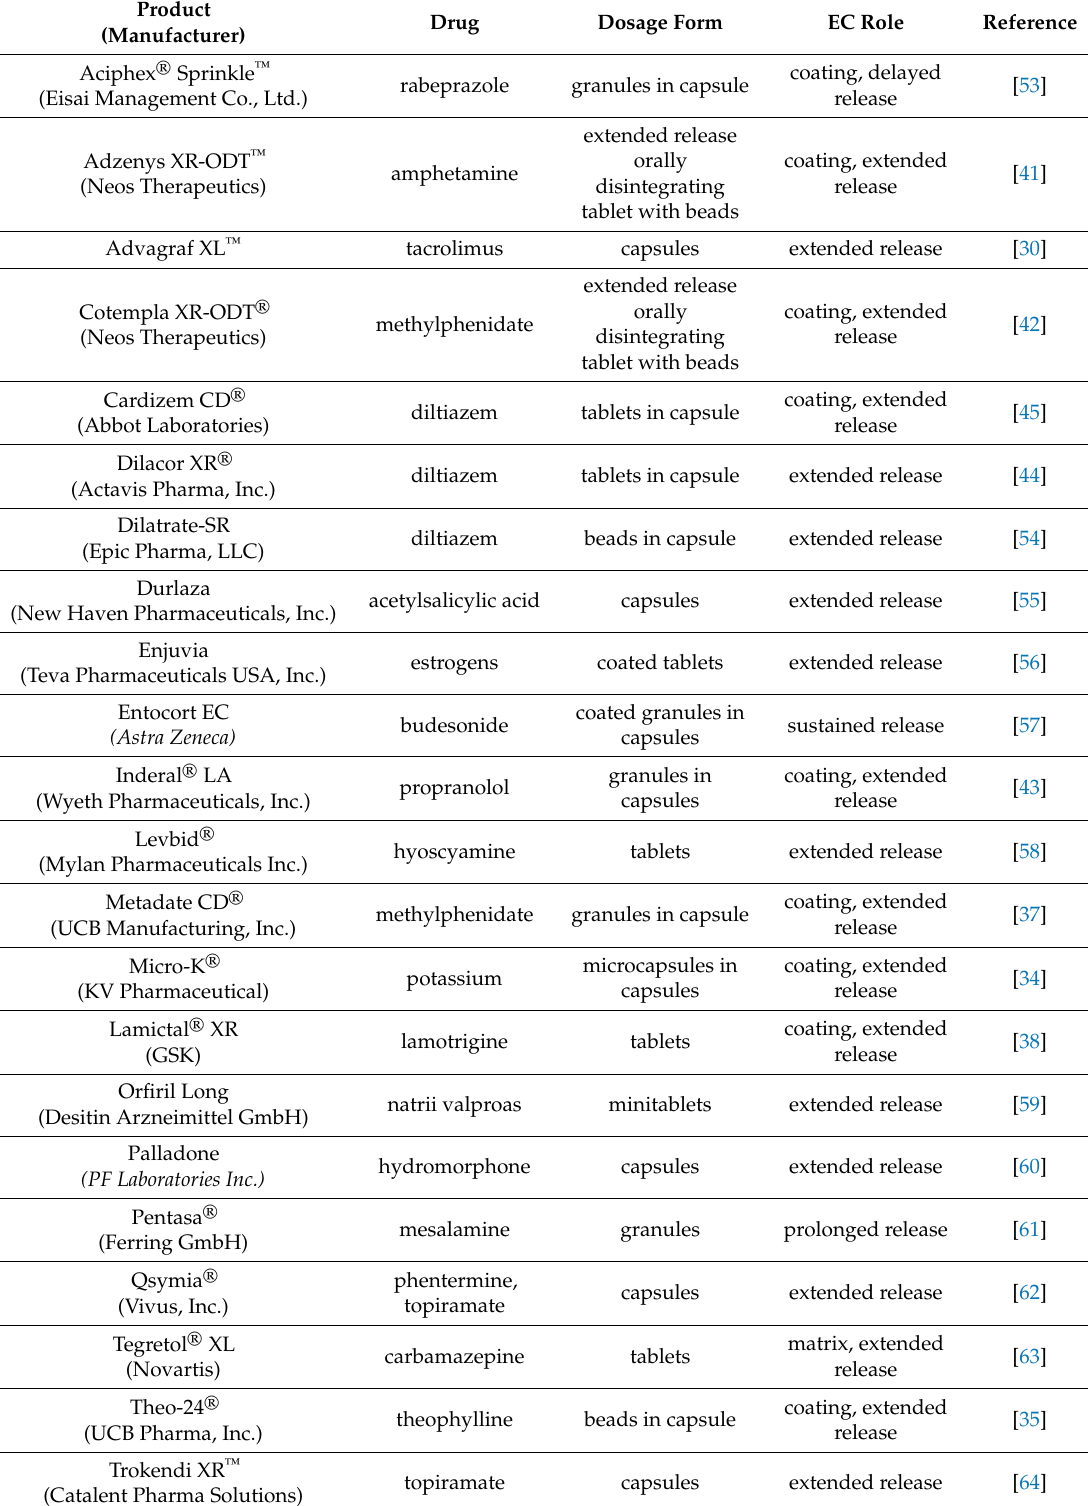
Table 2. Examples of commercially available oral solid dosage forms with EC as release modifier.